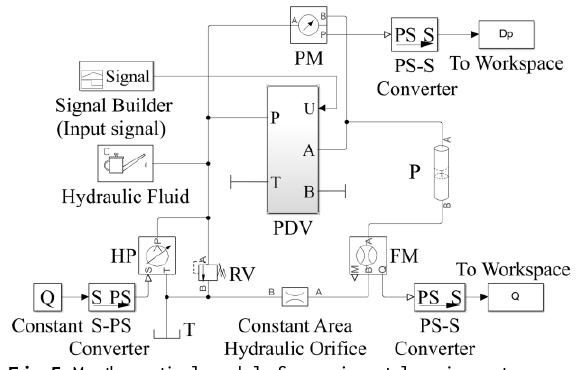
Fig. 5. Mathematical model of experimental equipment